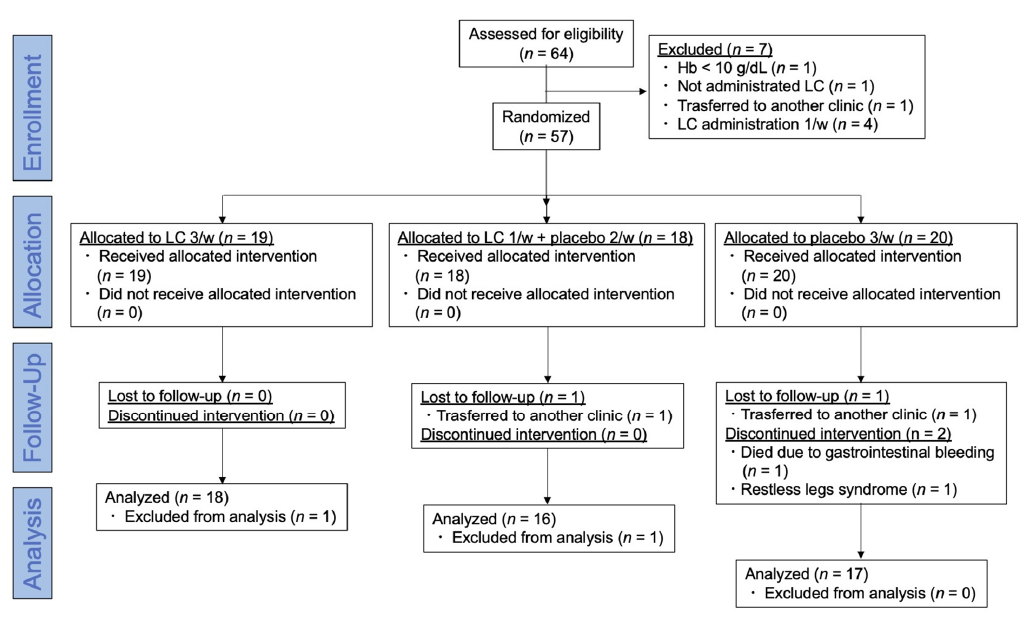
Figure 1. CONSORT flow diagram of this trial. Sixty-four hemodialysis patients were assessed for eligibility, and 57 were randomized and allocated to LC 3/week, LC 1/week + placebo 2/week, and placebo 3/week groups and followed up for six months. Hb: hemoglobin; LC: L-carnitine.